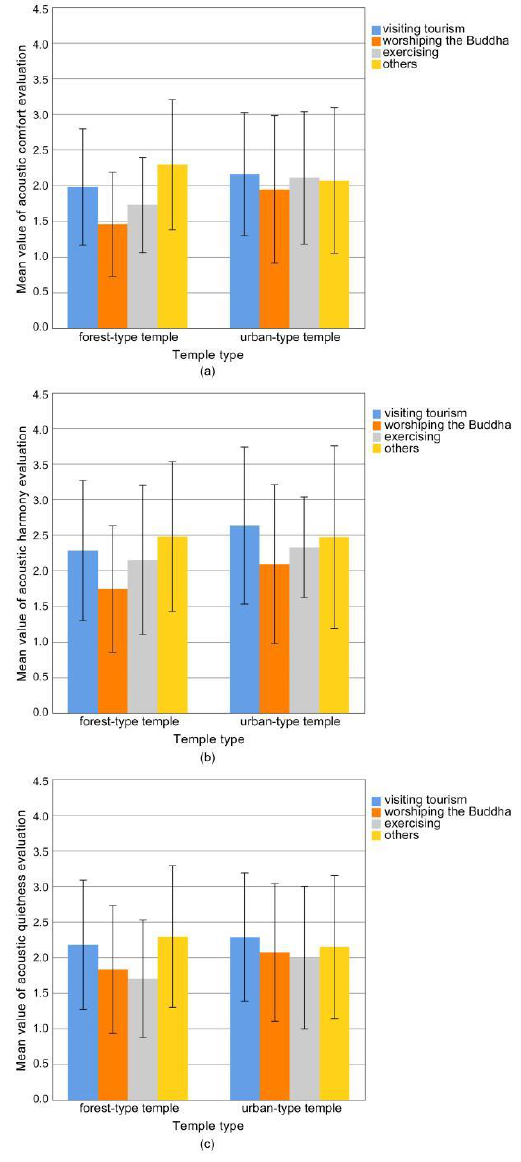
Figure 5. The evaluation value and standard deviation of acoustic environment by different respondents’ purpose: ( a ) comfort; ( b ) harmony; ( c ) quietness.